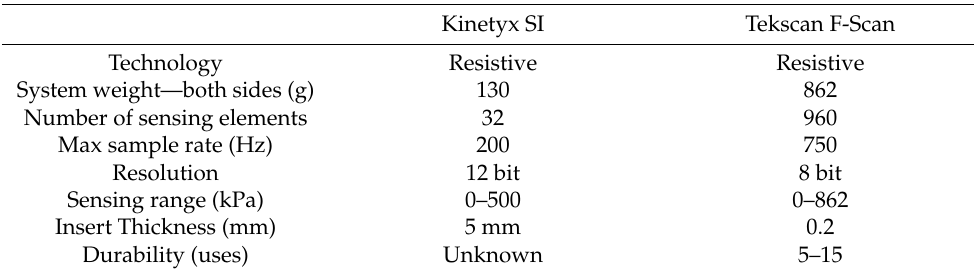
Table 1. Properties and listed specifications for each system. Information on the Tekscan system was taken from the Tekscan F-Scan data sheet [38]. Information on the Kinetyx SI system was supplied by the manufacturer upon